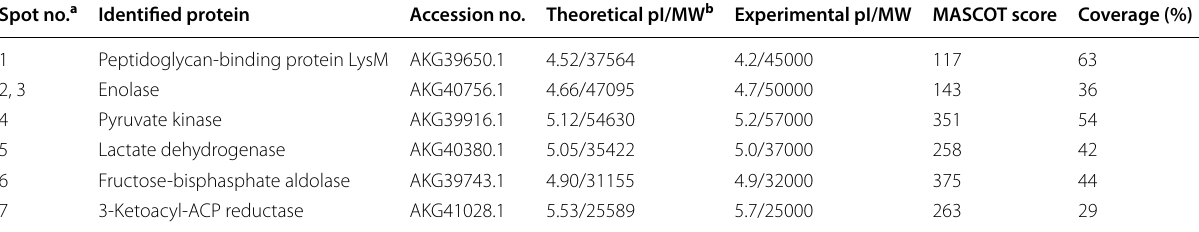
a Spot numbers correspond to those indicated in Fig. 1 b Theoretical pI and MW were calculated using the Compute pI/Mw server (http://web.expas y.org/compu te_pi/)